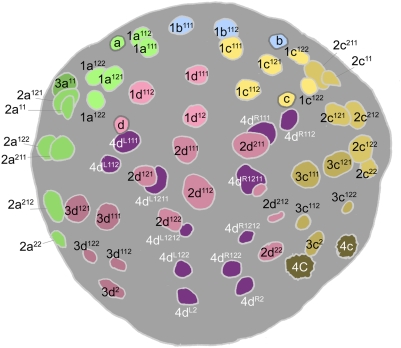
84-cell embryo, 955 minutes.This dorsal view shows how second and third quartet clones are increasingly extended along the animal-vegetal axis. The 2d212 cell is dividing. The asymmetry of both 4dLR121 is apparent, and the large 4dLR1211 nucleus is irregularly shaped.